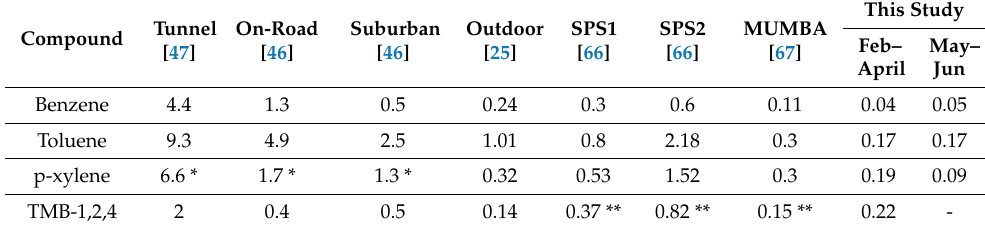
Table 6. Mean AVOC concentrations during the COALA-JOEYS 2019 campaign compared to previous studies in Australia. All concentrations are reported in ppb. TMB 1.2.4 = Trimethyl-benzene 1,2,4. The two columns represent the period where TMB 1.2.4 signal was recorded (Feb–mid-April) and the period without TMB measurements (mid-April–June). * Reported as the summed concentration of o-xylene and p-xylene. ** Reported as the summed concentration of TMB isomers.